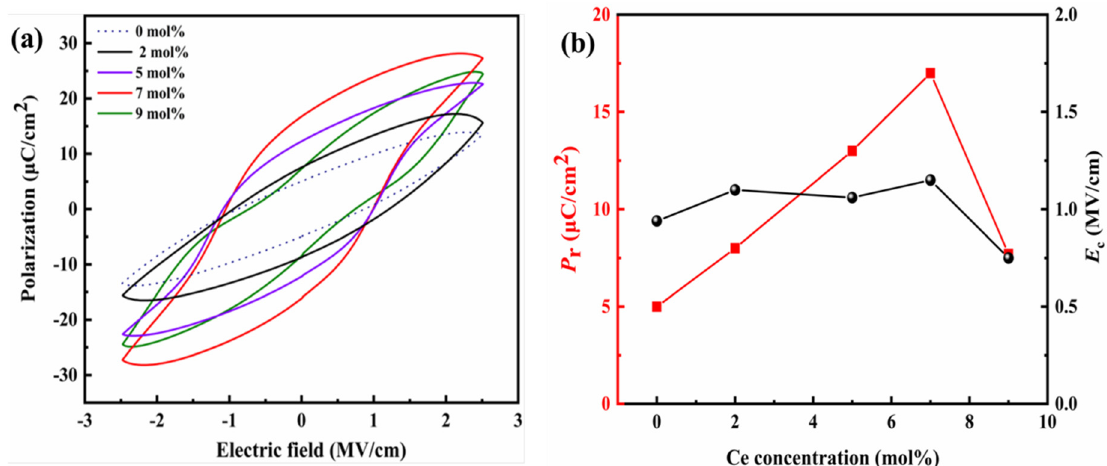
Figure 5. ( a ) P–E curves and ( b ) P r for Ce: HZO thin films with different Ce concentrations. Testing the relative dielectric constant versus electric field ( ε r – E ) curve is also an effec- tive method for characterizing the ferroelectric and dielectric properties of thin films [28].